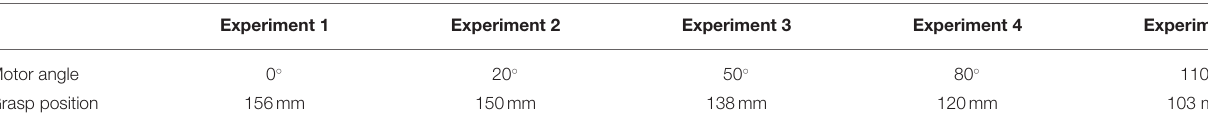
TABLE 2 | Geometric relationship between motor angle and grasp position of two-finger translational manipulator.